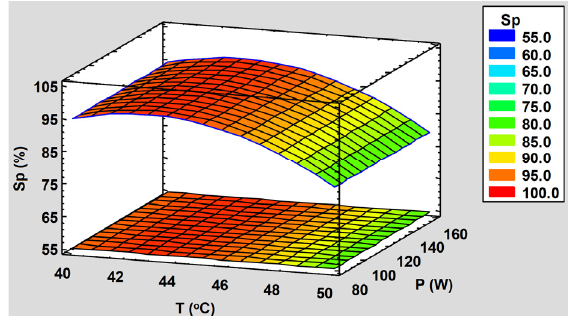
Figure 18. Effect of T and P on saponin content Sp.